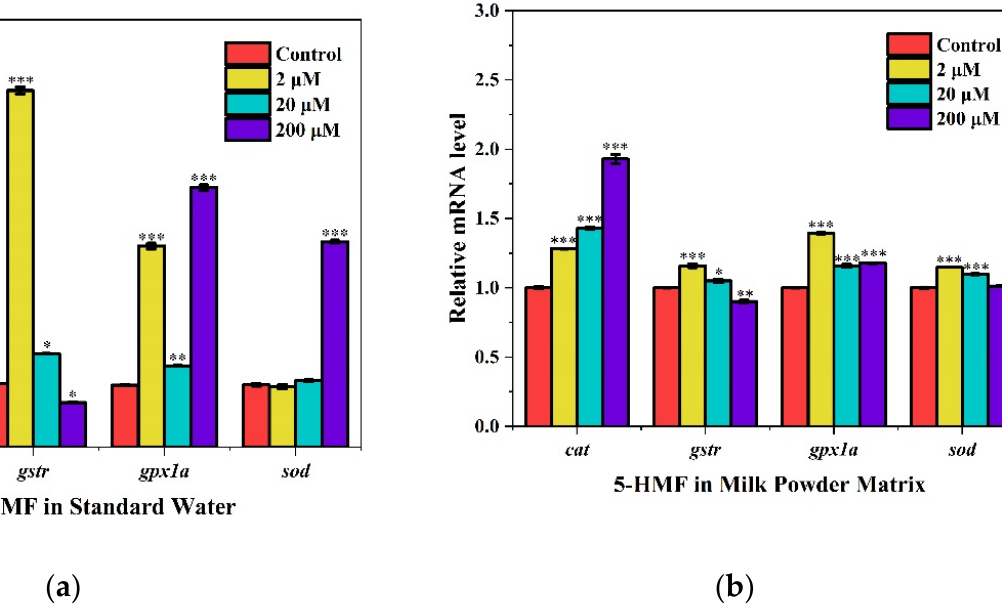
Figure 6. High, medium and low concentrations of 5-HMF in different matrices result in different degrees of altered gene expression of antioxidant systems. ( a ) Gene expression changes caused by 5-HMF in standard water; ( b ) Gene expression changes caused by 5-HMF in milk powder matrix. * p < 0.05, ** p < 0.01 and *** p < 0.001 vs. control.